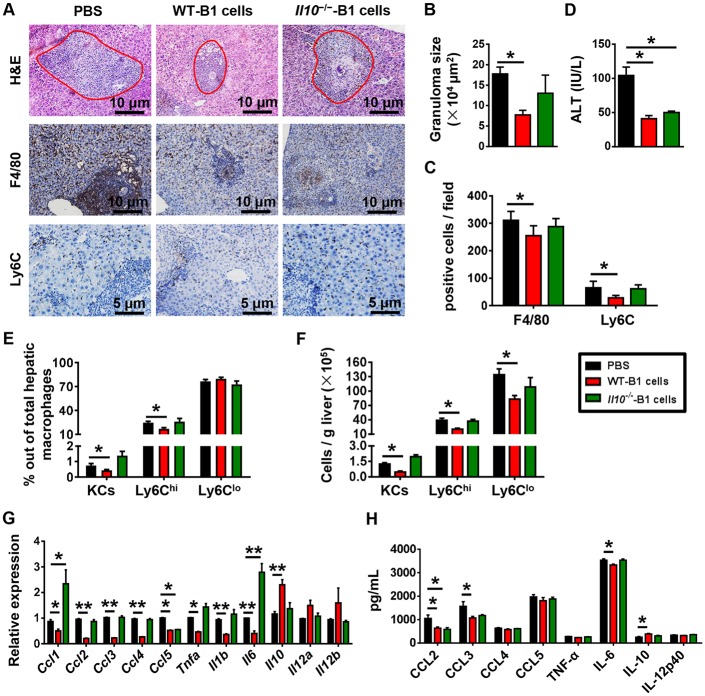
Adoptive transfer of WT PC B1 cells, but not Il10−/− PC B1 cells, attenuates S. japonicum-induced liver pathology in μMT mice.μMT mice were infected with 18–20 cercariae of S. japonicum. The adoptive transfer of B1 cells (2 × 106 cells) purified from the PC of WT or Il10−/− mice into μMT mice was performed 4 weeks after infection. Mice were sacrificed 6 weeks after infection. (A) H&E staining and immunohistochemical staining for F4/80 and Ly6C of liver tissues. Original magnification, × 200 for F4/80, × 400 for Ly6C. (B) Statistical analysis of hepatic granuloma sizes. (C) Numbers of F4/80- and Ly6C-positive cells per field. (D) Serum ALT levels. (E) Graphical summary showing percentages of indicated cell subsets out of total hepatic macrophages in infected μMT mice after cell transfer assayed by flow cytometry. (F) Numbers of indicated cell subsets in the liver of infected μMT mice after cell transfer analyzed by flow cytometry. (G) Quantitative PCR analysis of chemokine and inflammatory cytokine gene expression levels in the liver. (H) Hepatic chemokine and inflammatory cytokine protein expression levels were examined by CBA and ELISA. Data represent mean ± SD; n = 5–7 per group from two independent experiments. *p < 0.05, **p < 0.01.